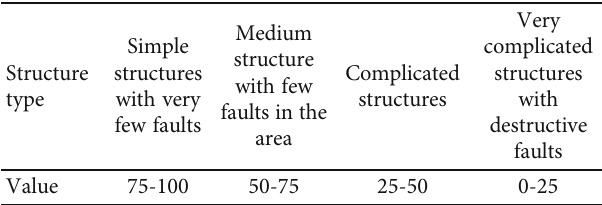
Table 4: Scoring table for structure